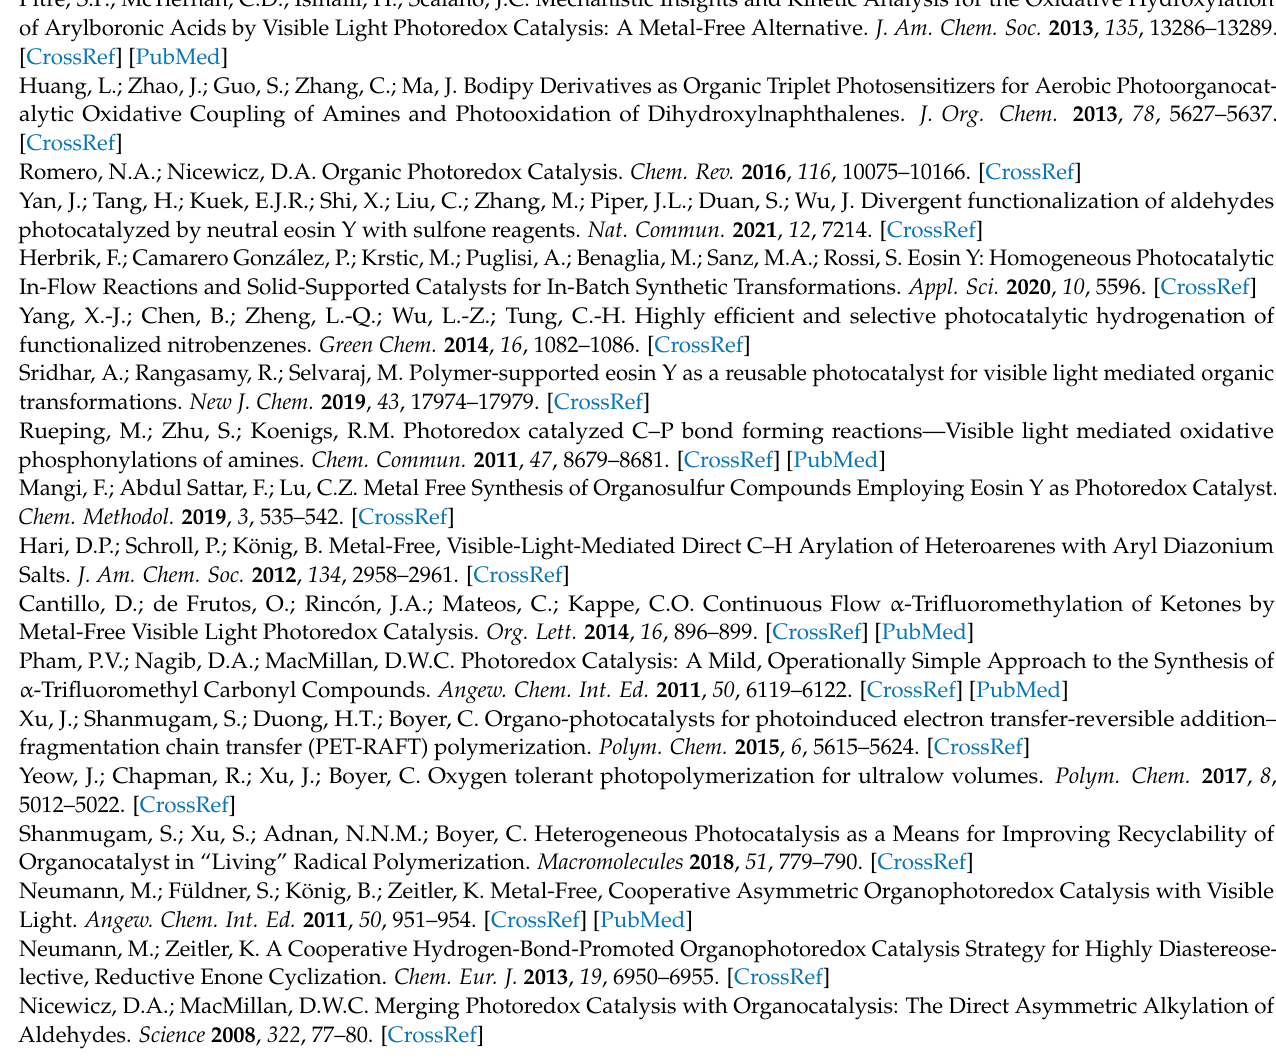
Figure S5: 1 H NMR (CDCl 3 ) spectrum of a crude reaction mixture of p -tolyl methyl sulfide